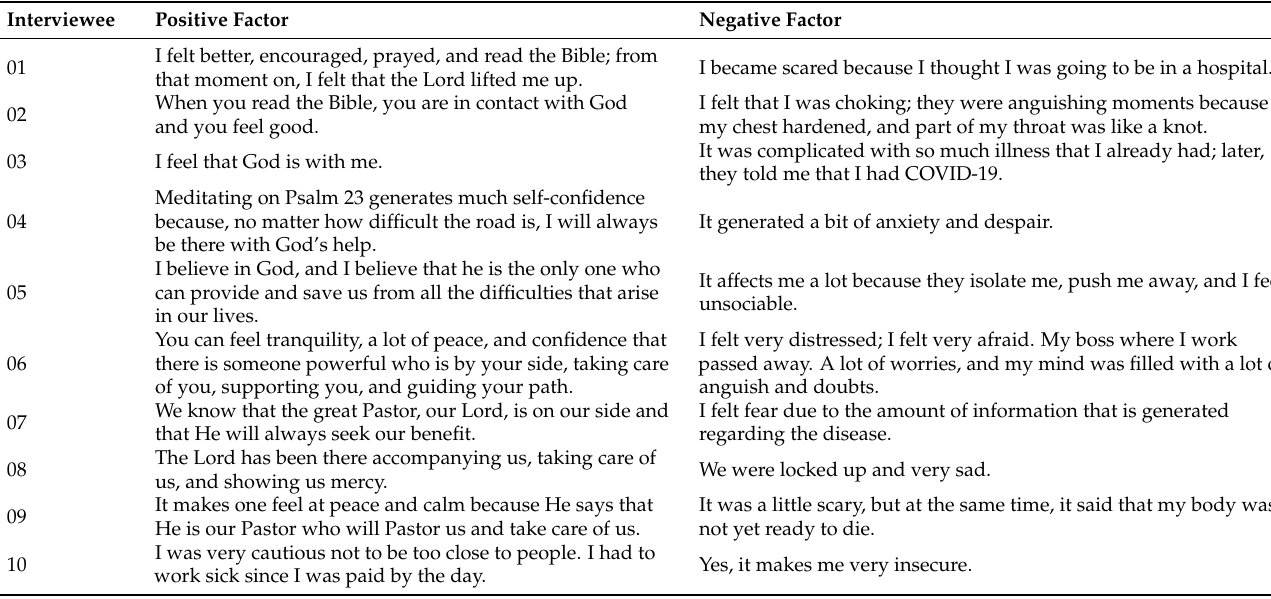
Table 2. Described polarity of each interviewee.